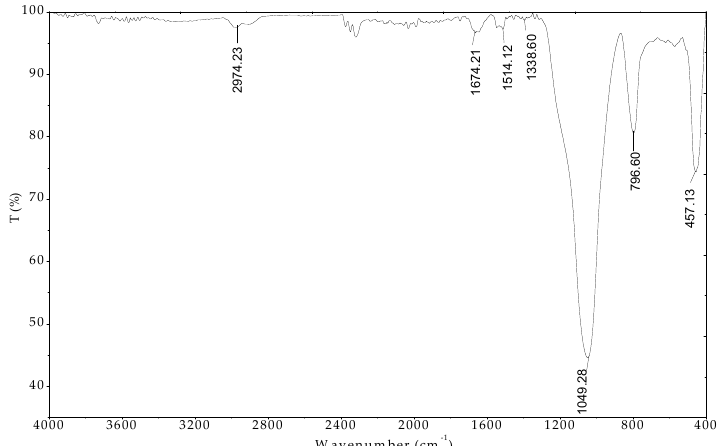
Figure 13. FTIR spectrum of nanosilica with protein modification after Ciprofloxacin (CFX) adsorption in the wave number range 400–4000 cm − 1 .